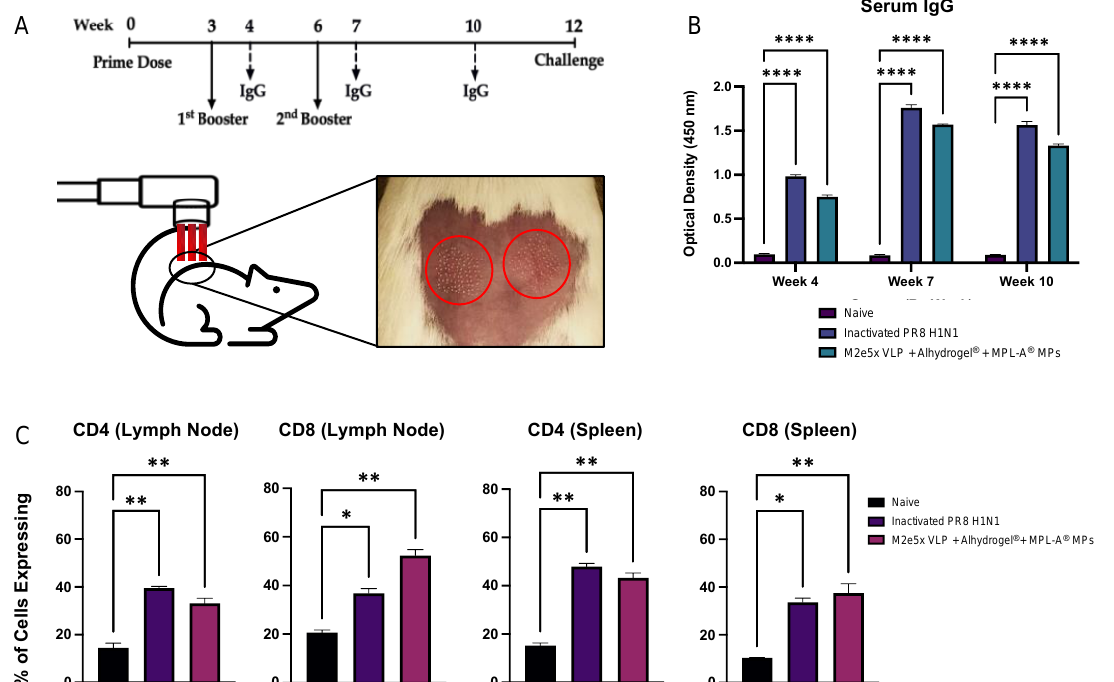
Figure 3. In vivo evaluation of adjuvanted M2e5x VLP MP vaccine. ( A ) Study design and laser ablation device used for immunizations in mice. The red circles highlight the micropores created by the P.L.E.A.S.E. ® ablative laser. ( B ) Serum IgG levels for weeks 4, 7, and 10 comparing Inactivated PR8 H1N1 and M2e5x VLP + Alhydrogel ® + MPL-A ® MPs to Naïve showed that mice that received monovalent inactivated PR8 (****p < 0.0001) and the experimental MP vaccine (****p < 0.0001) produced significantly higher IgG levels compared to naïve mice. The experimental vaccine, containing the antigen (M2e5x VLP) and adjuvants (Alhydrogel ® + MPL-A ® ) MPs was shown to induce high levels of M2e-specific antibodies in vivo . C) CD4 + and CD8 + T cells in lymph node and splenocyte populations in Inactivated PR8 H1N1 and M2e5x VLP + Alhydrogel ® + MPL-A ® BSA MPs were significantly higher compared to Naive. P-